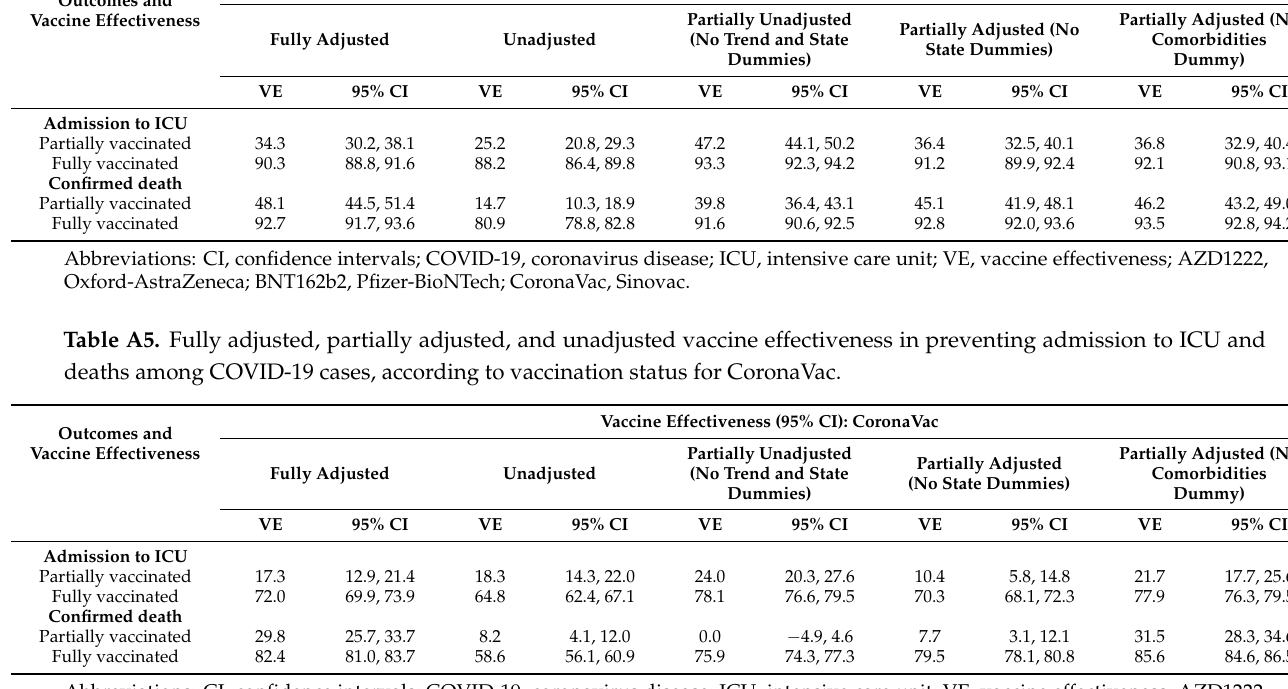
Table A4. Fully adjusted, partially adjusted, and unadjusted vaccine effectiveness in preventing admission to ICU and deaths among COVID-19 cases, according to vaccination status for BNT162b2. Outcomes and Vaccine Effectiveness